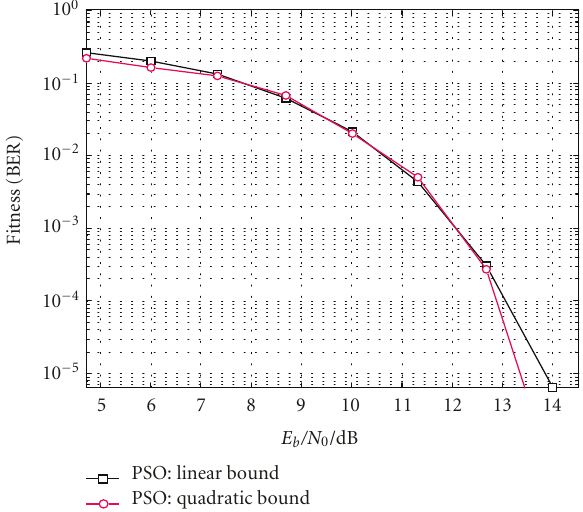
Figure 6: BER performance for di ff erent division bound functions 1–4m.